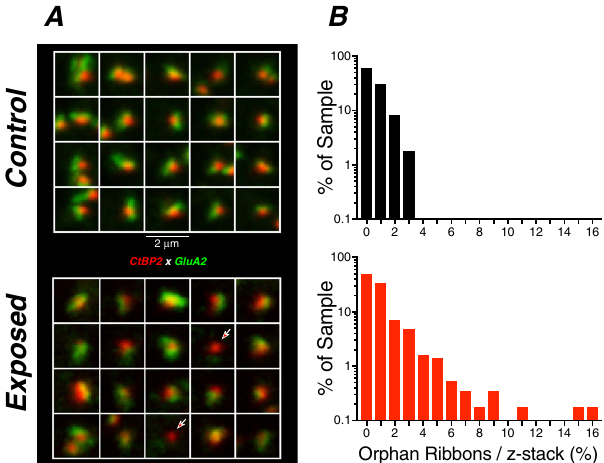
Figure 7. Orphan ribbons, lacking apposed glutamate receptor patches, were rare in blast-exposed ears. ( A ) Selected synaptic complexes from the control and exposed z-stacks shown in Fig. 6. Red arrows indicate orphan ribbons. ( B ) The histograms compare the % orphan ribbons per z-stack for all samples from 2–22 kHz, as compiled for all control (black) and exposed (red) cases. All data were gathered at 1 wk post